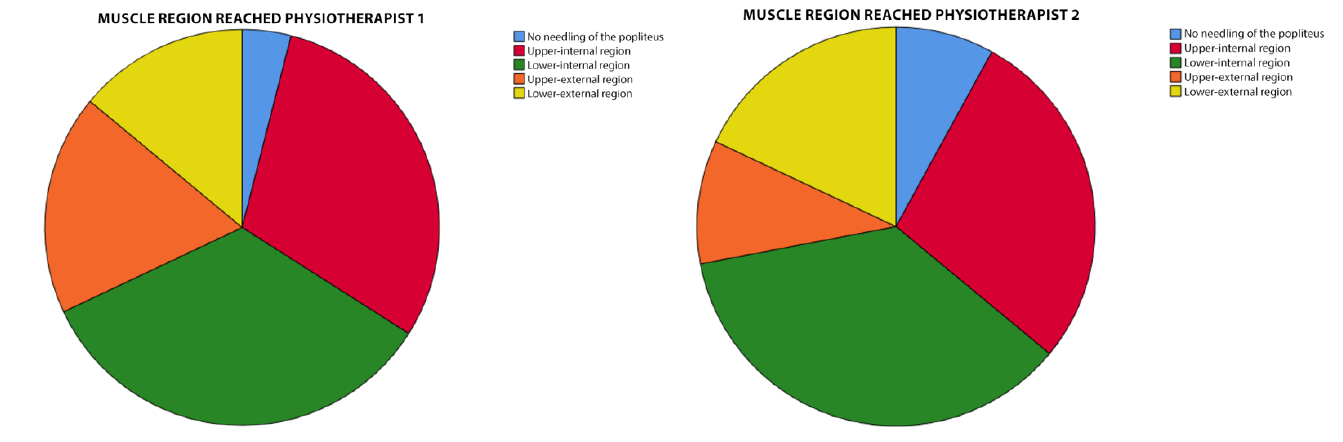
Figure 5. Sector diagram of the regions dotted by each therapist.